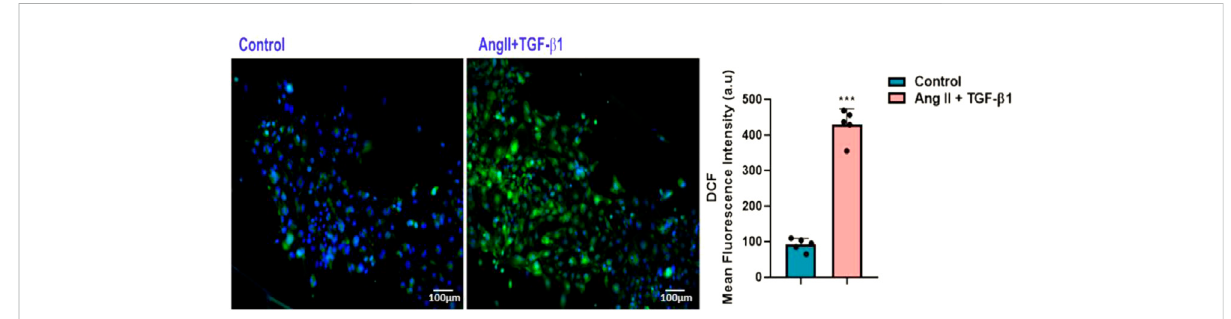
FIGURE 3 Measurement of DCF fl uorescence as a measure of reactive oxygen species (ROS) in hiPSC-derived cardiomyocytes: (left side) Fluorescence microscopic images of intracellular ROS production by DCF staining (green) in hiPSC-CMs stimulated with AngII + TGF- β 1 for 48 hours and unstimulatedhiPSC-CMs takenascontrolcells;(rightside)Averageintensity ofDCF fl uorescencevaluesinunstimulatedandstimulatedhiPSC-CMs. Nuclei were shown in blue fl uorescence by DAPI dye staining. The images were quanti fi ed using the ImageJ program for 5 independent